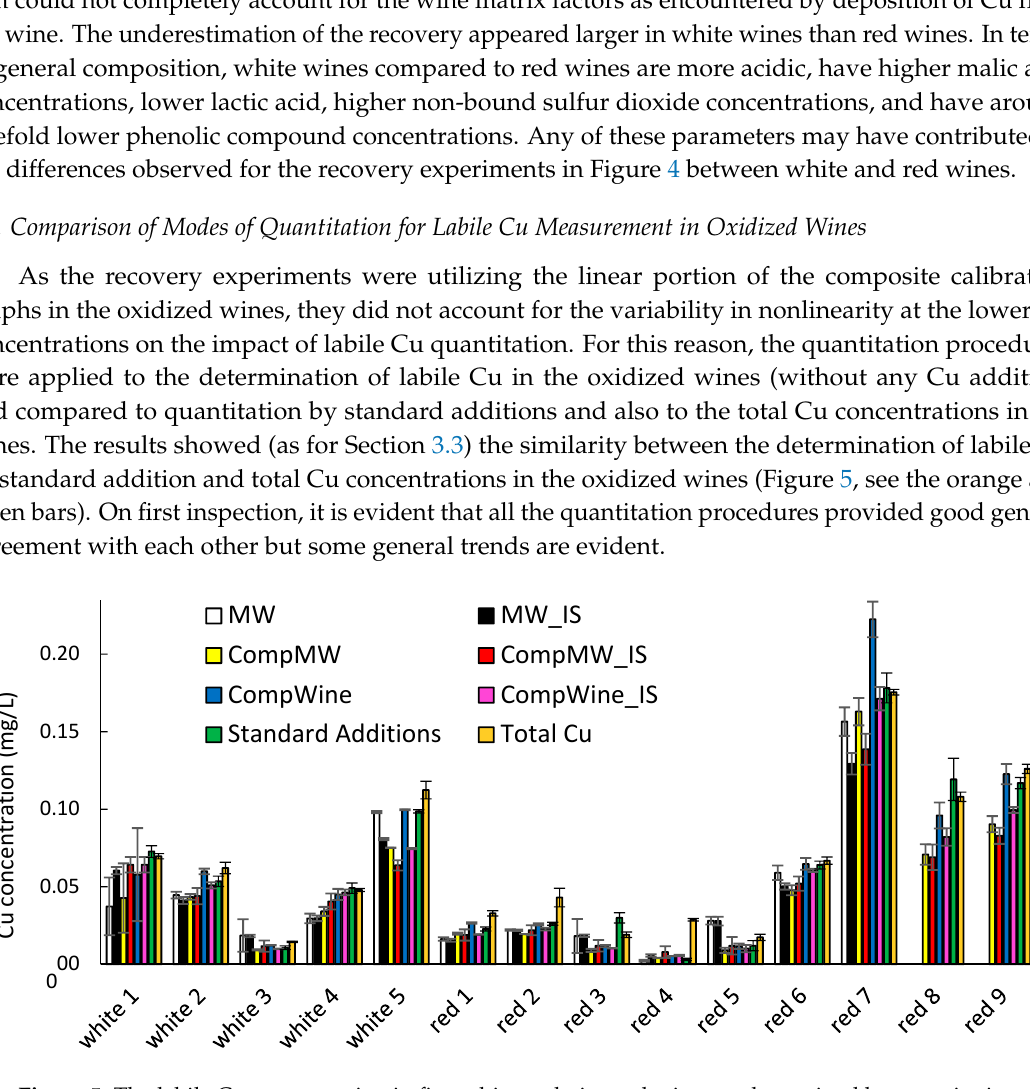
Figure 5. The labile Cu concentration in five white and nine red wines as determined by quantitation methods 1–6. The error bars indicate the standard deviation of the determination. Red wines 8 and 9 were not quantitated by methods 1 and 2.